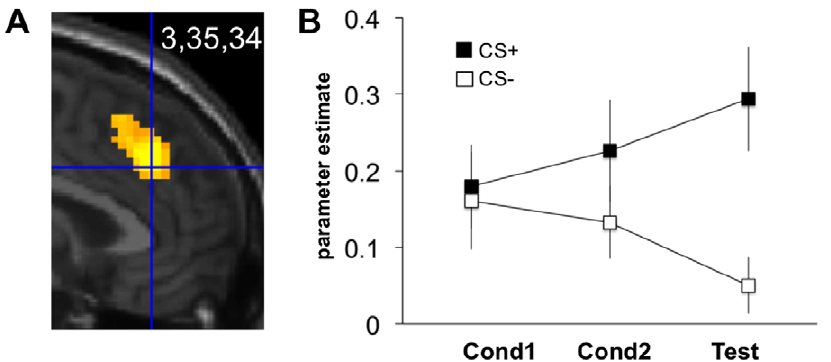
Figure 4. Uninstructed fear (study 2): Rostral dmPFC/dACC activation. ( A ) Contrast ‘unpaired CS + . CS 2 ’ at testing (UF-Test run). Display threshold: p , 0.001 uncorrected. Activations superimposed on a canonical structural image. ( B ) Parameter estimates from the peak voxel during all three runs (UF-Cond1, UF-Cond2, UF-Test). Error bars: s.e.m.